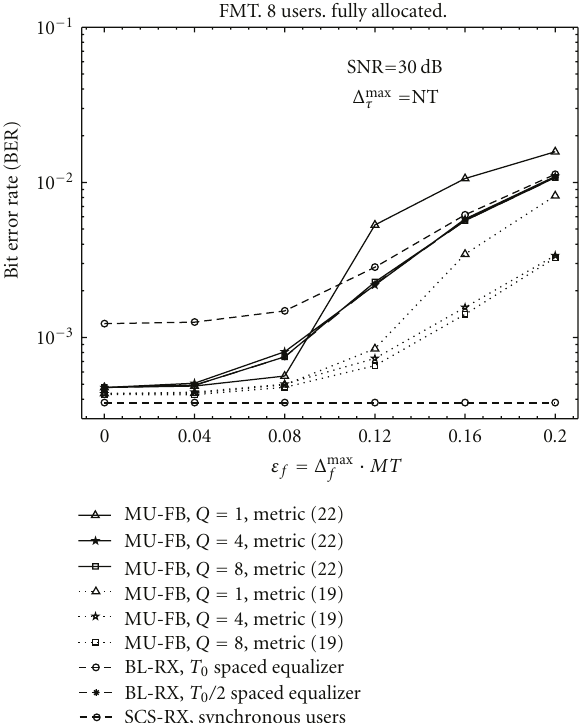
Figure 3: BER as a function of frequency o ff set. 8 interleaved users fully allocated. Comparison of the compensation metrics for di ff erent values of Q. FMT with M = 32 and N = 40